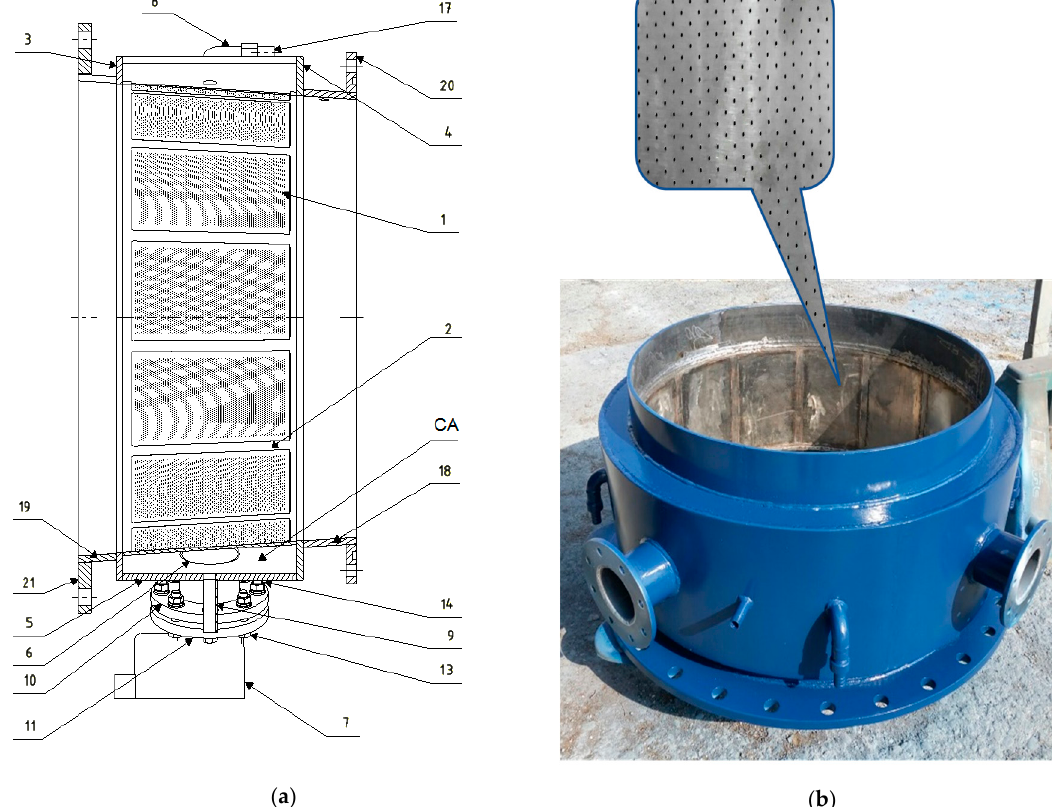
Figure 5. Water aeration system in hydraulic turbines, ( a ) section view, ( b ) photo of the aeration section (CA—air chamber, 1. perforated plates, 2. support grid, 3. upstream wall, 4. downstream wall, 5. an outer wall, 6. intake pipes, 7. valves, 8. air injection pipes, 9. drain plug, 10. flat flanges, 11. valve flange, 12. gasket, 13. hexagonal screws, 14. hexagon nut, 15. washer A, 16. grower R washer, 17. adapter, 18. upstream section, 19. downstream section, 20. upstream flange, 21. downstream flange).